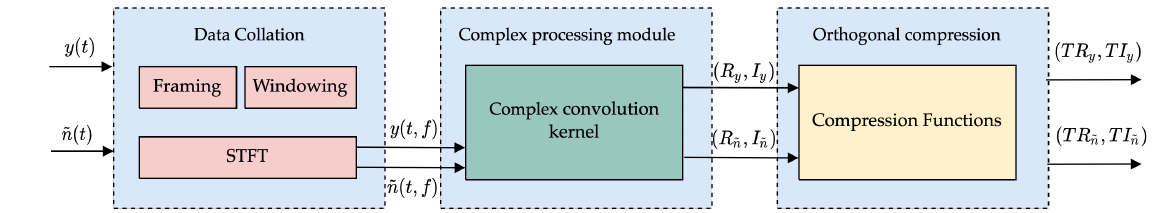
Figure 5. Complex-type orthogonal compression pre-processing structure.